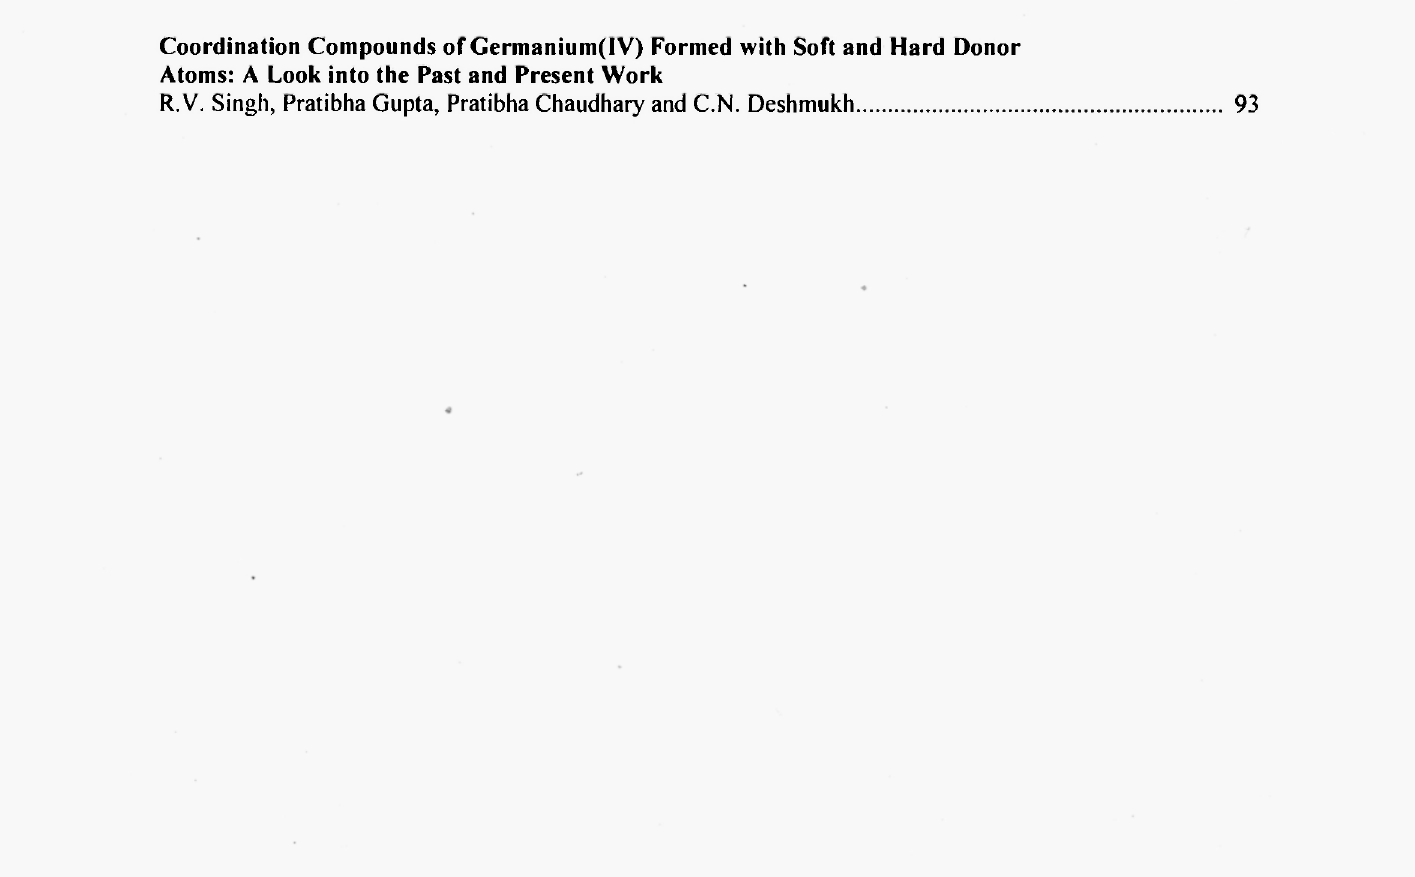
Coordination Compounds of Germanium(IV) Formed with Soft and Hard Donor Atoms: A Look into the Past and Present